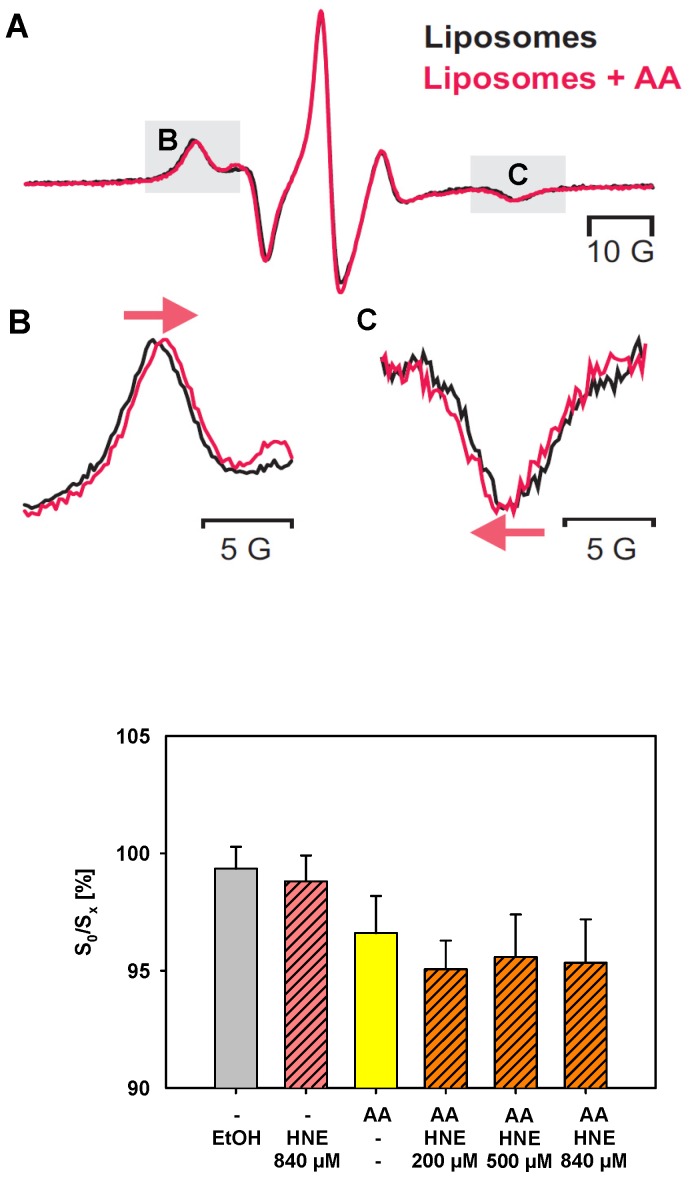
Alteration of order parameters in the presence of arachidonic acid (AA) and/or hydroxynonenal (HNE).Liposomes (5 mg/ml) were made from E.coli lipid. The concentration of the spin label 5-doxyl stearic acid (5-DSA) was 7.5 nmol/(mg lipid). Graph (A) shows a typical EPR spectrum of 5-DSA incorporated in liposomes in the absence and presence of AA. Details of the spectral shift in the low-field and the high-field line caused by AA are shown in (B) and (C), respectively. (D) The order parameter measured in control liposomes (S0) was set to 100 and all other order parameters (Sx) were expressed in relation to this value. S0 and Sx were measured with or without additives (AA, HNE, Ethanol).